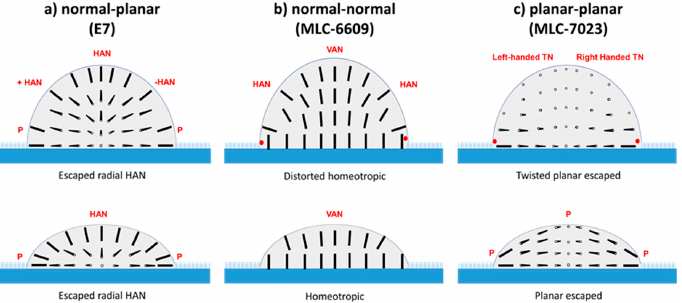
Figure 8. Potential alignment configurations for hemi-cylindrical and flattened cylindric-sectional droplets with various alignments at the air–nematic and glass–nematic interfaces: ( a ) normal-planar, ( b ) normal-normal; and ( c ) planar-planar. VAN denotes vertical aligned nematic, P is planar aligned, HAN is hybrid aligned nematic and TN is twisted nematic.